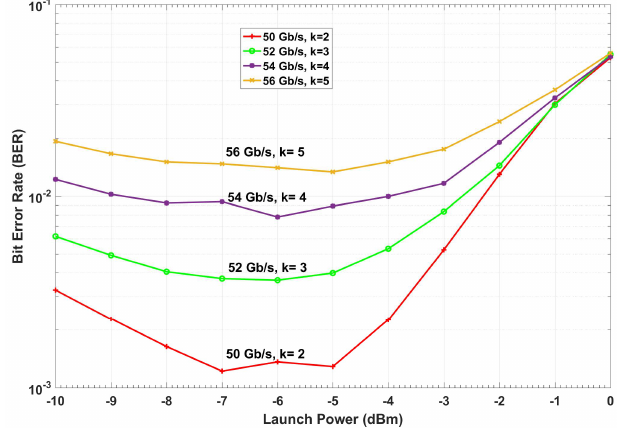
Figure 17. The simulation results for the prospective BER predicted in executive (CDS in prediction mode).